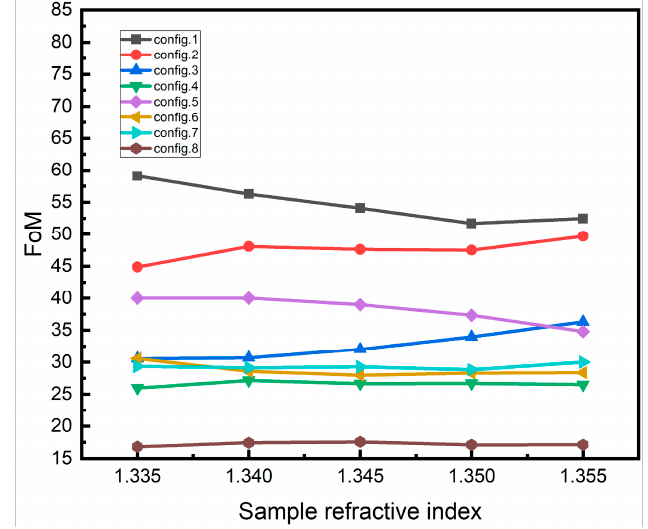
Figure 5. The figure of merit obtained by changing the refractive index of analyte.